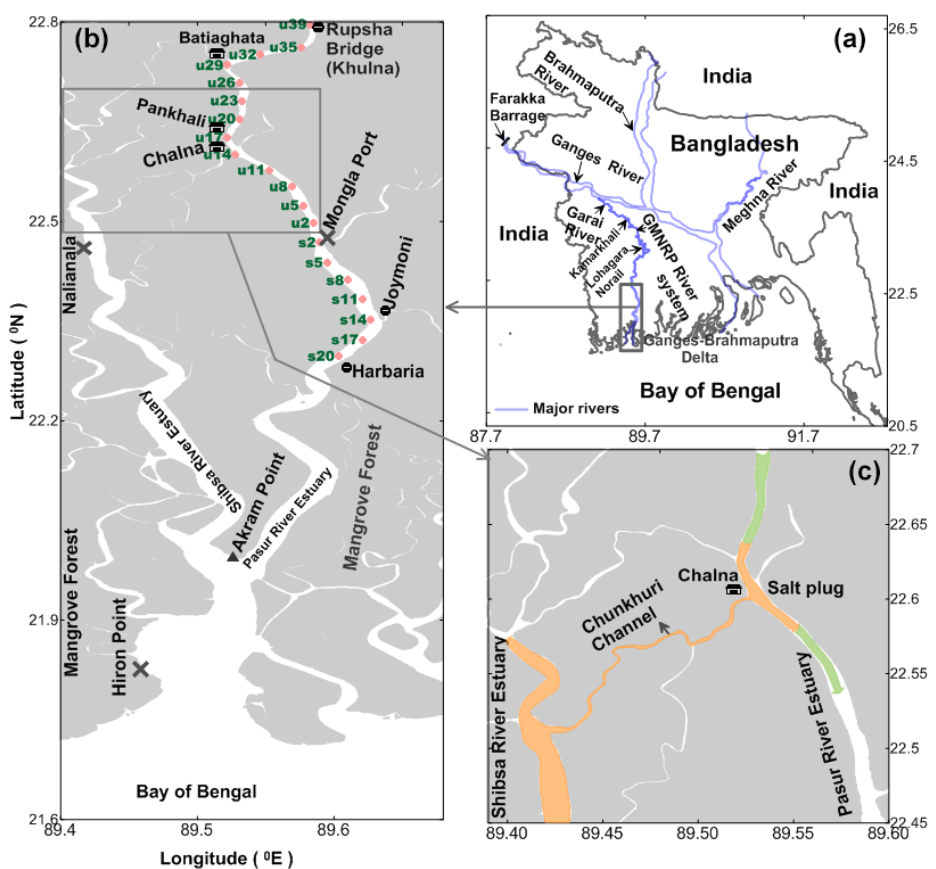
Figure 1. (a) Map of the complex topographical features of the multi-channel Pasur River–Shibsa River estuarine system in the southwestern coastal zone of Bangladesh. (b) Conductivity–temperature–depth (CTD) recorder stations are shown as pink solid circles in the Pasur River. The cross symbols denote the locations of the tidal stations at Hiron Point and Mongla Port. (c) The export of salt water from the Shibsa River estuary to the Pasur River estuary through the Chunkhuri Channel, creating a salt plug. The map was generated using Golden Software Surfer 9.0